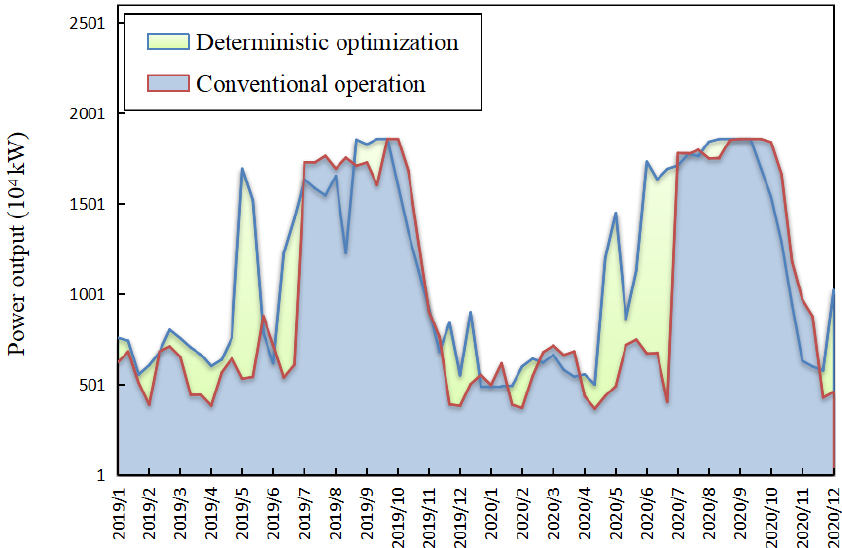
Figure 2. Comparation of output process between conventional operating and deterministic opti- mization results.